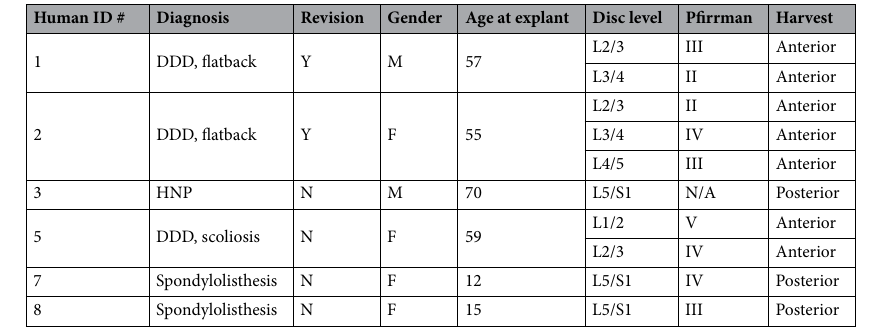
Table 1. List of human